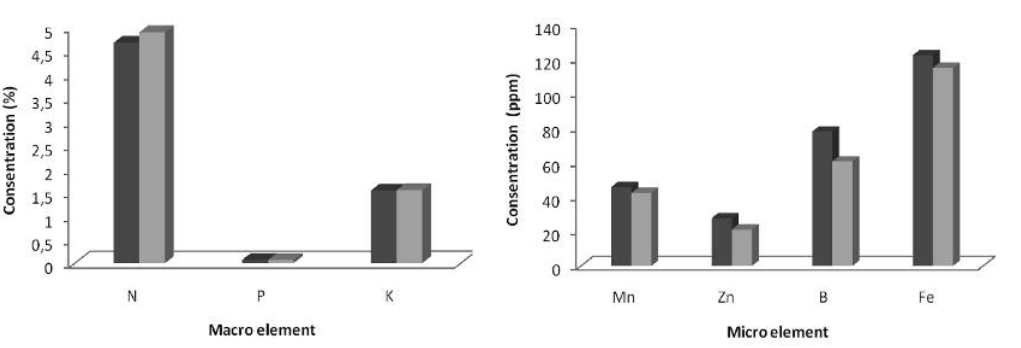
Figure 1. Consentration of nurtetional elements of female buds. Black and gray columns stand to sprayed and control trees respectively